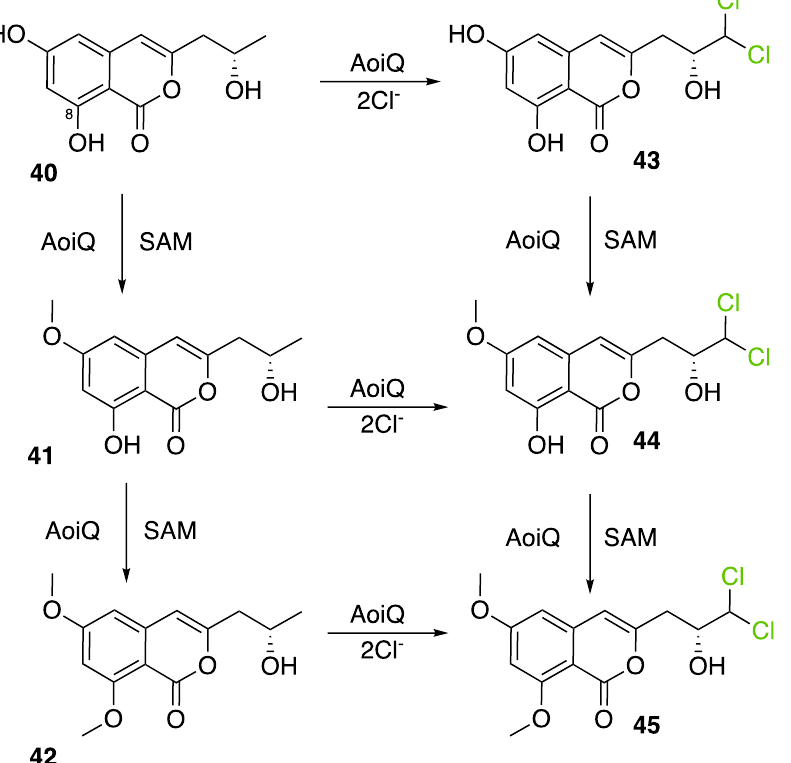
Figure 21. Biosynthetic route examples of the hybrid enzyme AoiQ described in Aspergillus oryzae on diaporthin derivatives de- O -methyldiaporthin ( 40 ), diaporthin ( 41 ), 8-methoxyldiaporthin ( 42 ), de- O -methyl-dichlorodiaporthin ( 43 ), dichlorodiaporthin ( 44 ), and 8-methoxyl-dichlorodiaporthin ( 45 ).